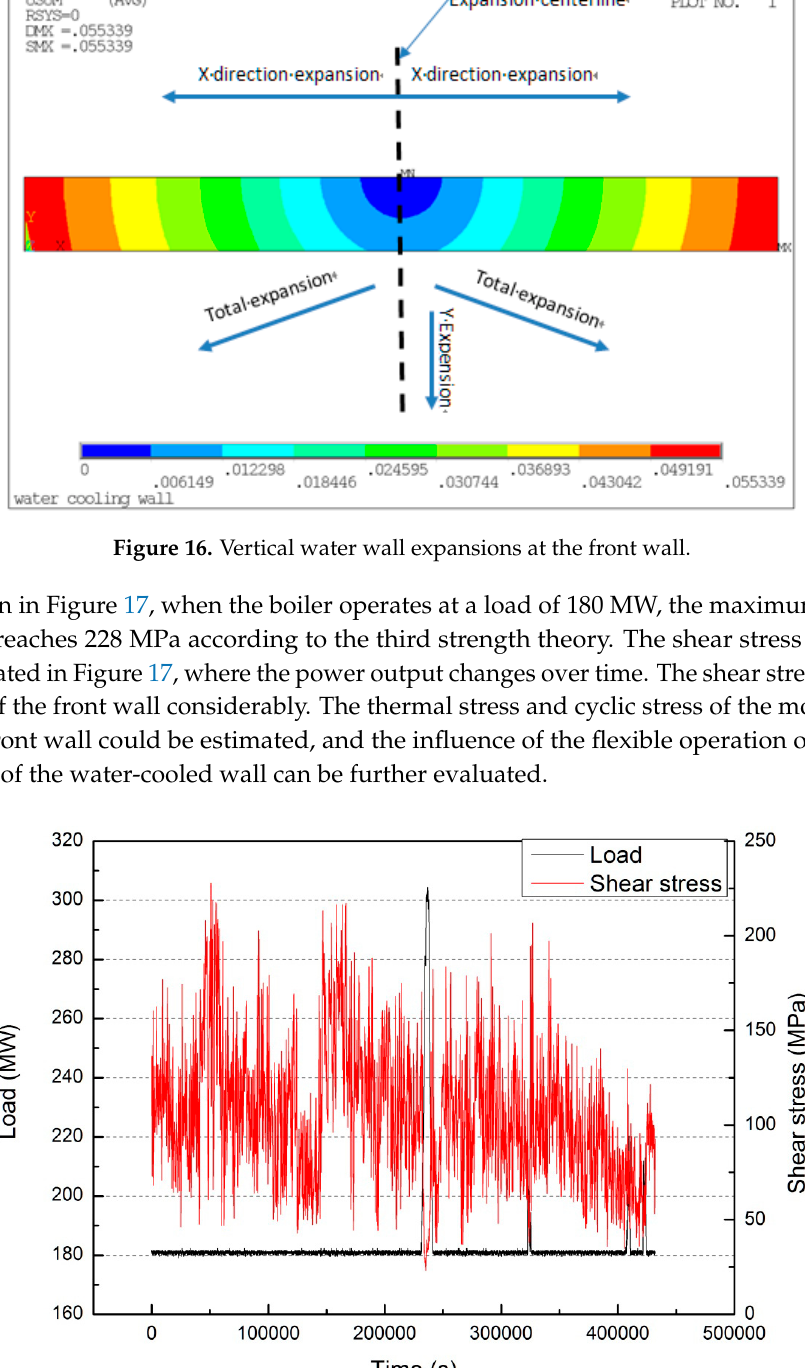
Figure 15. Thermal stress contour of the Y direction under the highest tube temperature difference.